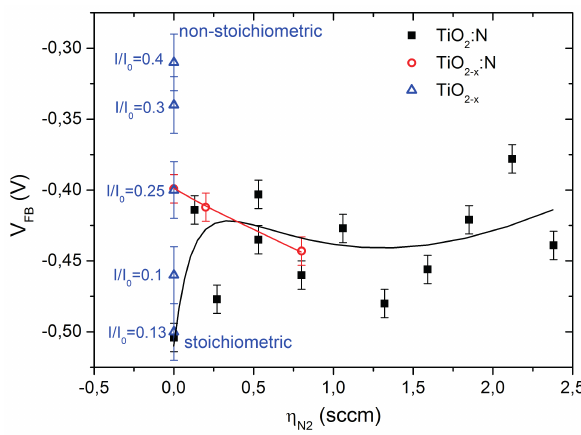
vs. nitrogen flow rate η FB , TiO :N, TiO :N) in the 2 2 2-x